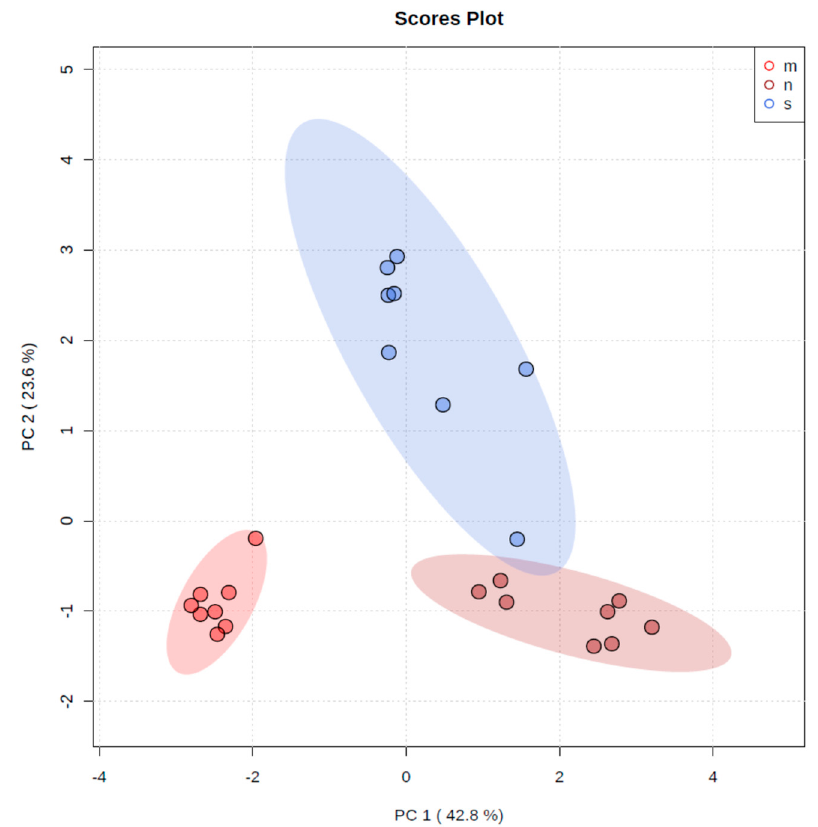
Data are shown as mean values ± standard deviation (SD); s—standard group; m—group receiving zinc in microparticles; n—group receiving zinc in nanoparticles. For the comparison of groups, the Kruskal–Wallis test was performed. There were no statistically significant differences.